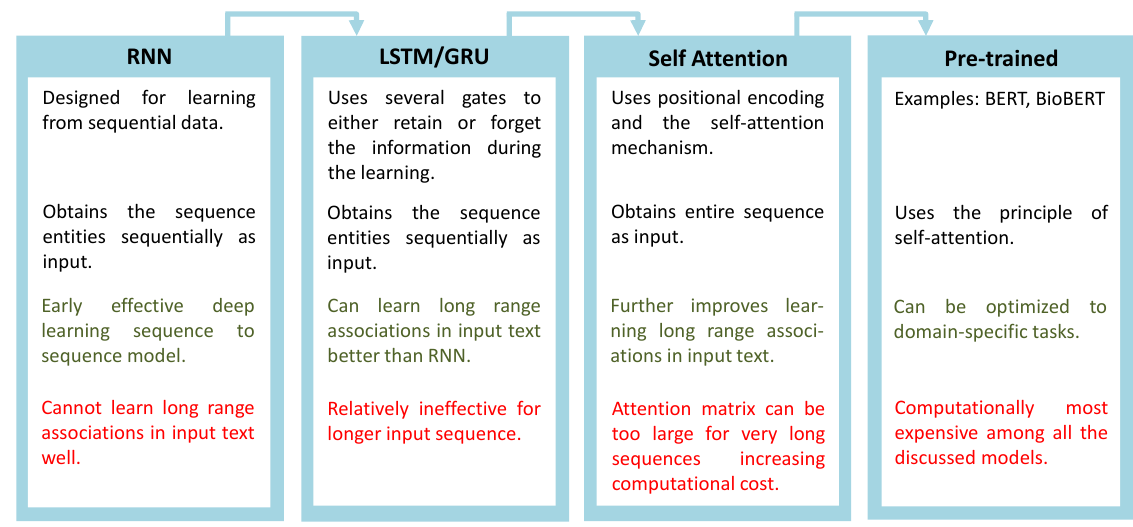
Figure 2. The evolution of sequence-to-sequence models for relationship extraction. Some pros and cons of the models are marked in green and red,